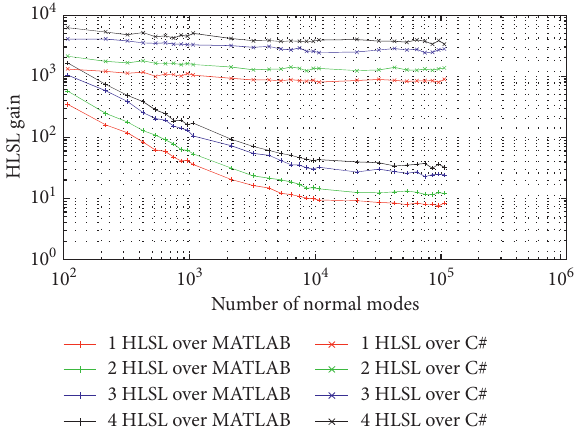
Figure 12: HLSL gain over MATLAB code or C# code on four